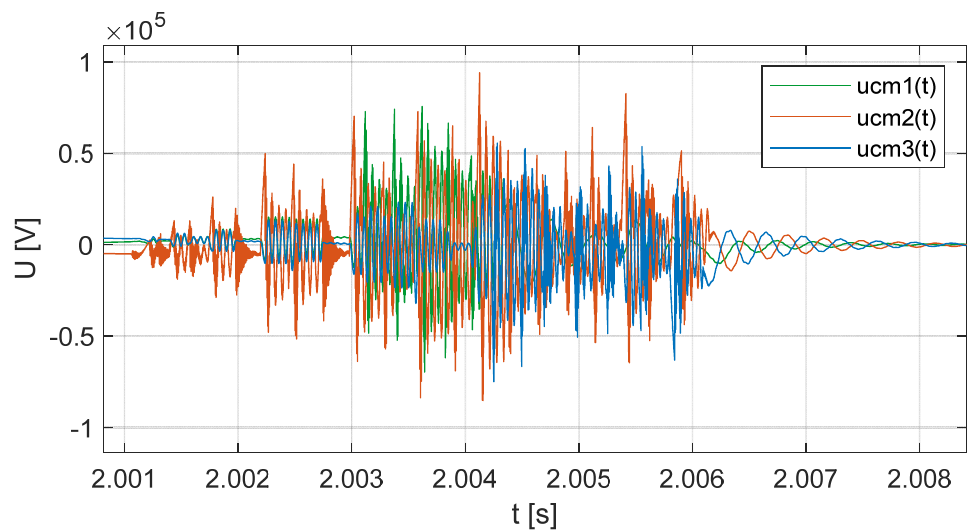
( t ) (Clark transformation). Source: own (𝑡) (Clark transformation). Source: own calcula- M (cid:3262)